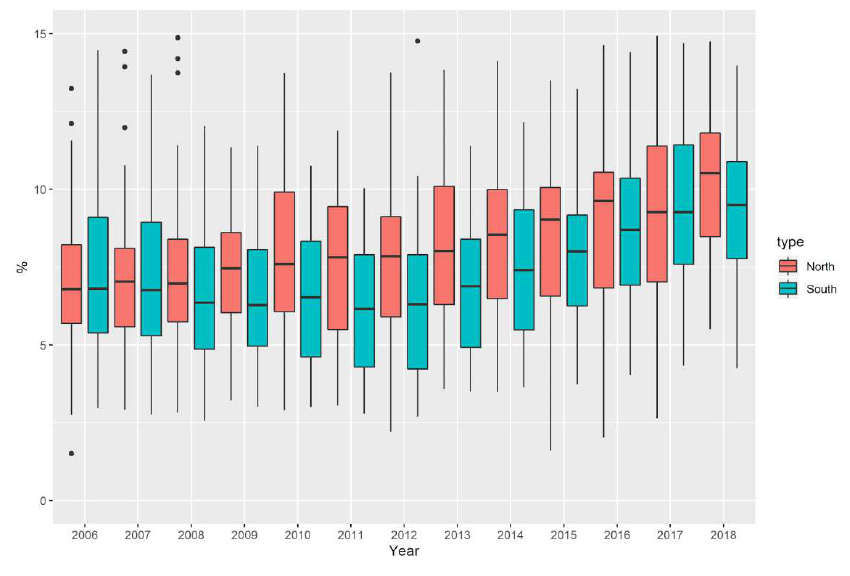
Figure 6. Cash-to-total assets ratio (2006–2018)